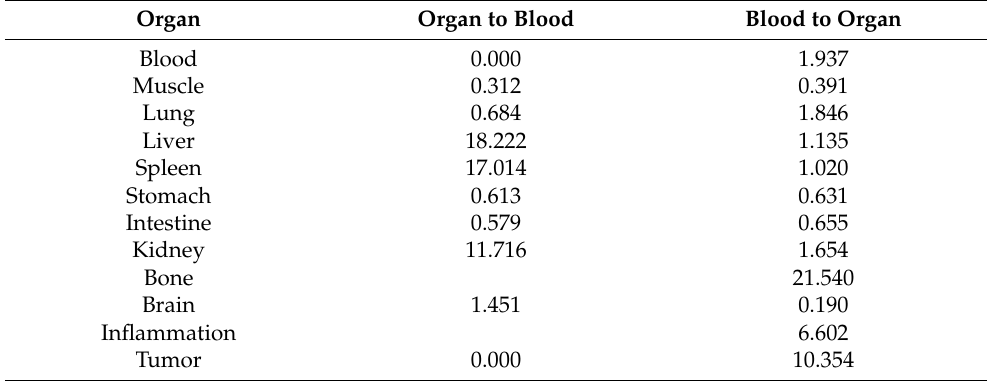
Table 2. Coefficients of transfer, 1/day, for 89 Zr-oxalate (mice with tumors). Organ Organ to